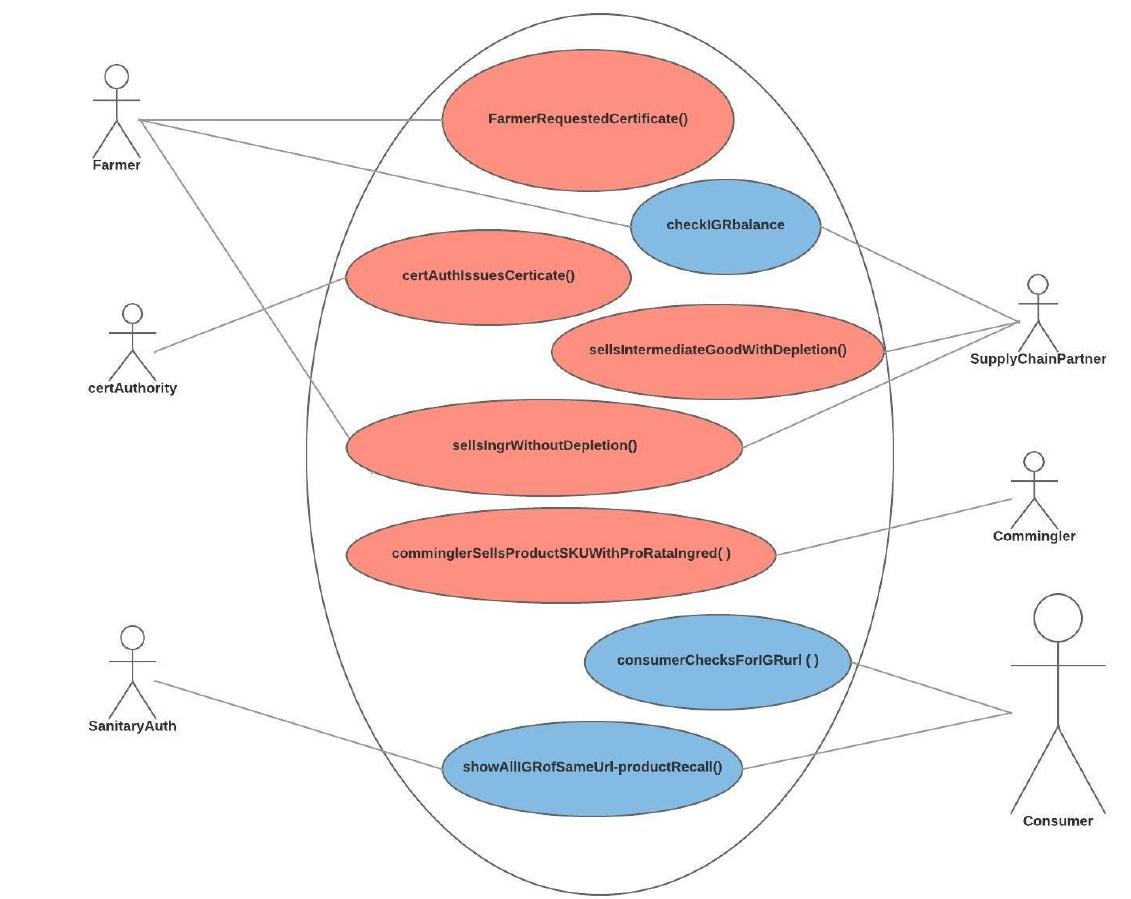
Figure 2. Traceability and Ingredient Certification use case (adapted from